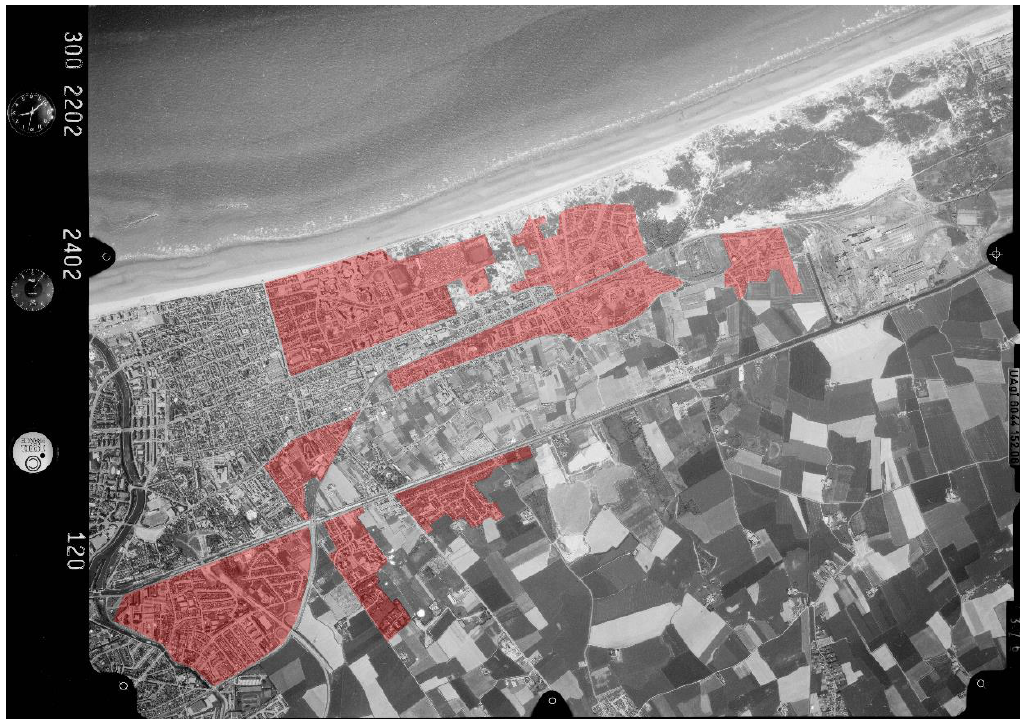
Figure 4. East part of Dunkirk, Leffrinckoucke, in 1985, with extensions of the city since 1957 highlighted in red. Picture of the service “remonter le temps” from the French National institute of Geographic and Forest Information (IGN).